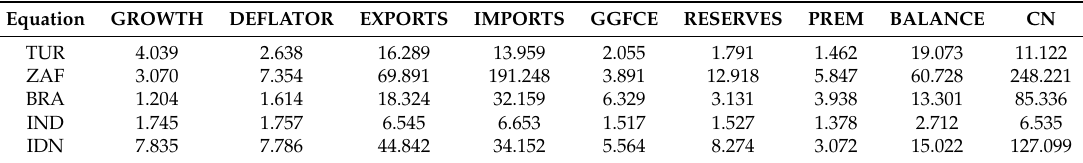
Table 8. Variance inflation factor (VIF) and CN values.